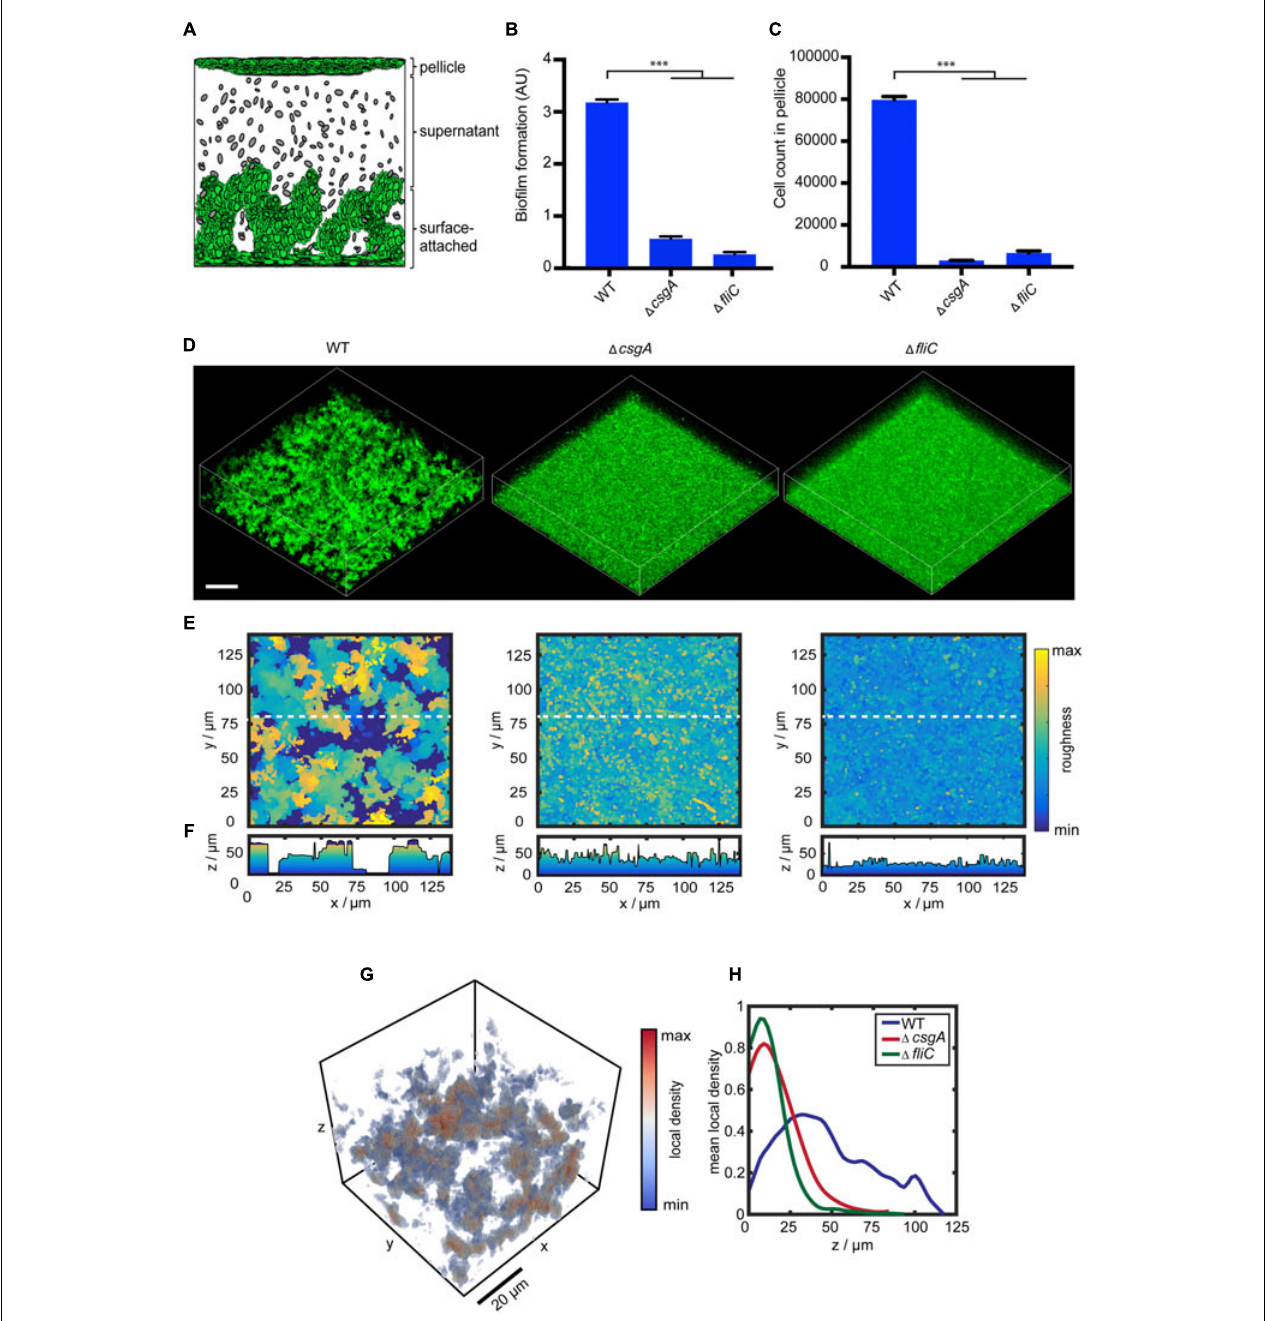
FIGURE 1 | Curli fibers and flagella are required for structure formation in submerged Escherichia coli biofilms. (A) Schematic representation of submerged E. coli biofilms grown in microtiter plates, indicating three fractions corresponding to the pellicle, supernatant and surface-attached cells. Note that the structures are not drawn to scale (see text for details). (B) Biofilm formation by wild-type strain W3110 and mutants lacking either curli ( (cid:49) csgA ) or flagella ( (cid:49) fliC ) that were grown under static conditions at 30 ◦ C for 24 h. Biofilm formation was quantified using crystal violet (CV) staining, with CV values normalized to the optical density shown in arbitrary units (AU). ∗∗∗ indicates P < 0.0001 according to unpaired t -test. Standard errors from three independent experiments are indicated. (C) Number of cells counted per 60 s in the pellicle fraction of submerged biofilms, measured using flow cytometry. (D) Confocal fluorescence microscopy images (maximum projection) of eGFP-expressing cells (carrying pVM42) in static biofilms grown in microtiter plates at 30 ◦ C for 24 h. Scale bar, 40 µ m. (E) Top views and corresponding (F) roughness profiles of submerged biofilms shown in (D) . The color scale shows roughness values from lowest (blue) to highest (yellow). (G) Visual representation of calculated local density (see Materials and Methods for details) for a subset of the intact submerged biofilm shown in (D) . As indicated by the color scale bar, red values correspond to dense regions, while blue values represent regions with low local density. (H) Profiles of mean local density along the biofilm height ( z -axis) for W3110 (WT; blue), (cid:49) fliC (green), and (cid:49) csgA (red).